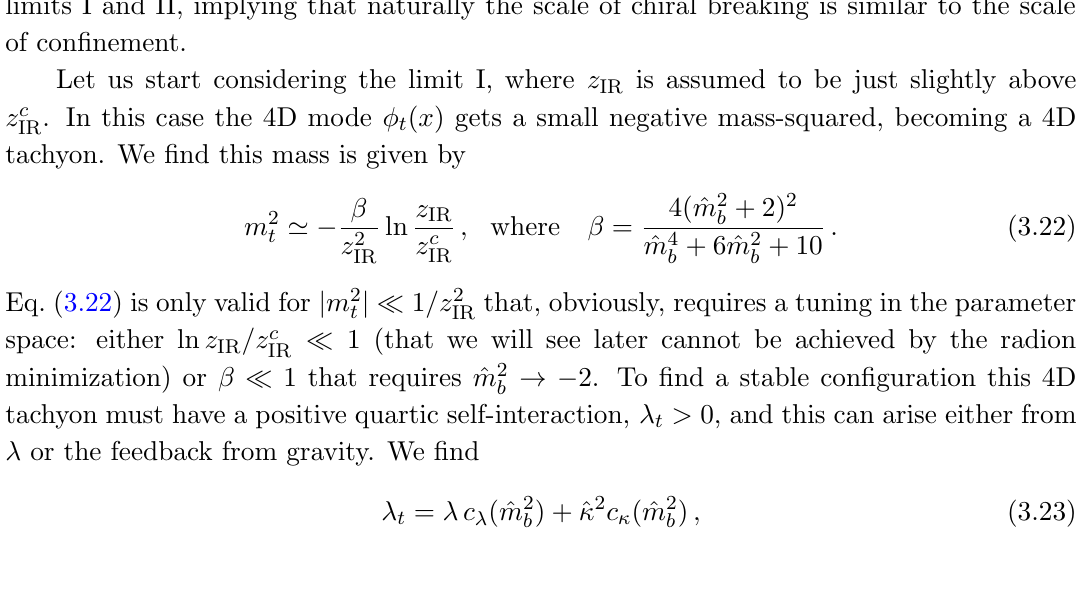
(cid:3) (cid:24) 1 =z . The origin of the logarithm in eq. (3.20), that will play an important UV UV